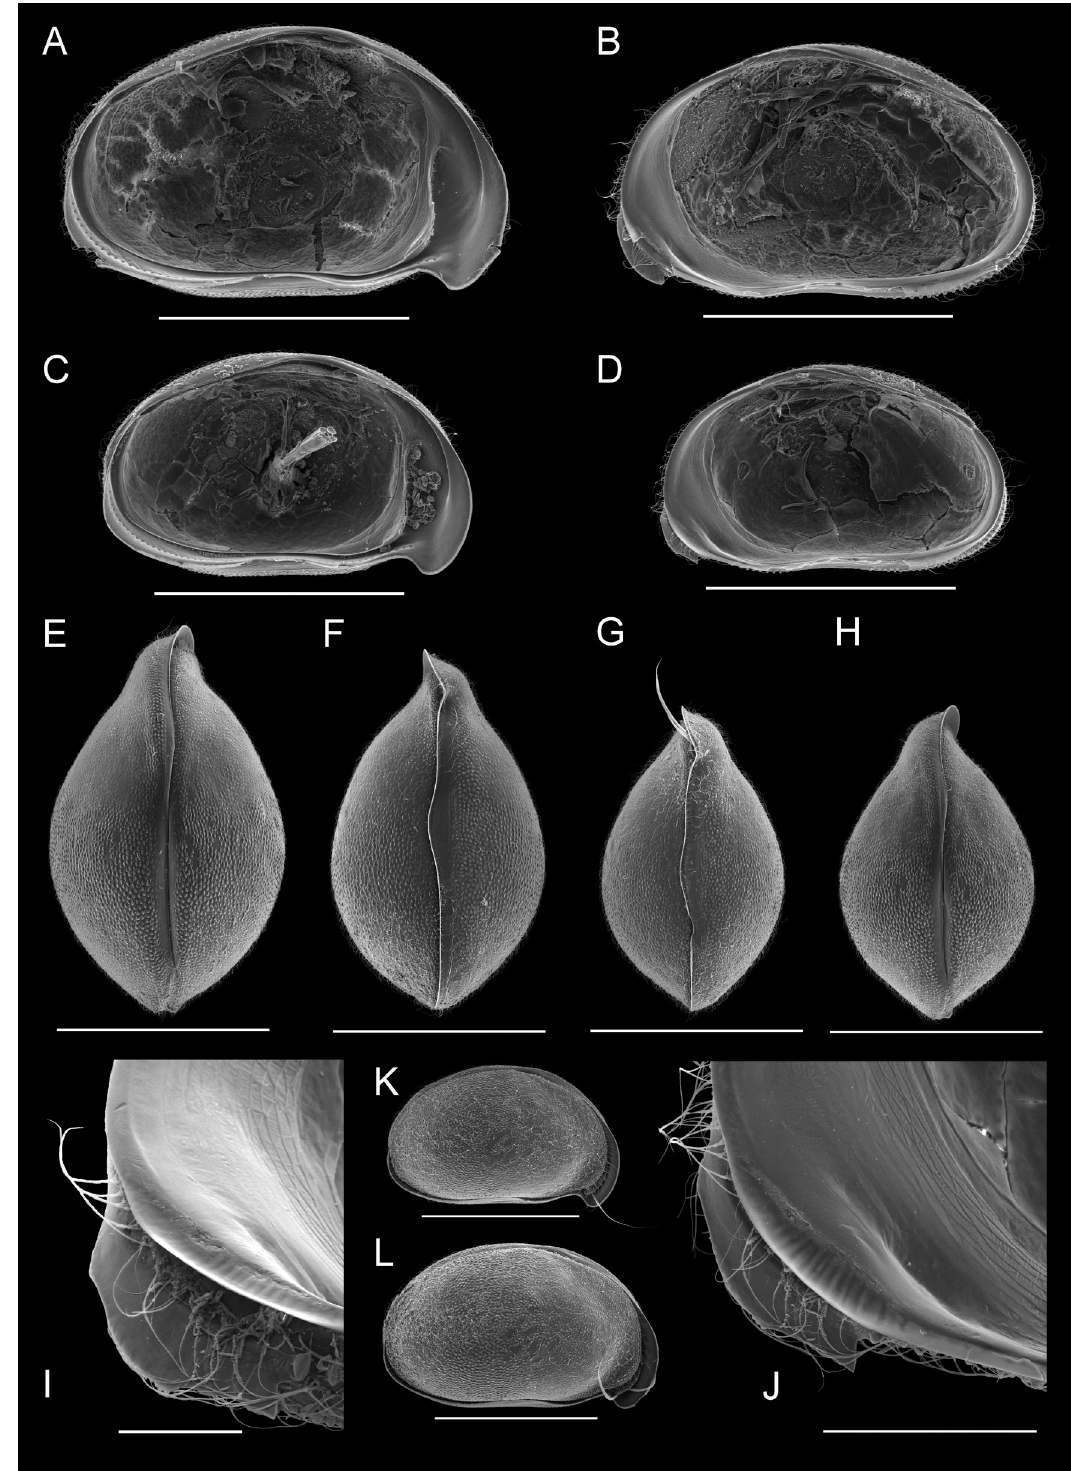
Fig. 7. Bennelongia regina sp. nov., all from Horseshoe Lagoon, QLD (Type locality). A . ♀, LVi (W40061). B . ♀, RVi (W40061). C . Holotype ♂, LVi (W40060). D . Holotype ♂, RVi (W40060). E . ♀, Cp dorsal (W40067). F . ♀, Cp ventral (W40066). G . ♂, Cp ventral (W40063). H . ♂, Cp dorsal (W40062). I . Holotype ♂, RVi detail anteriorly (W40060). J . Holotype ♂, RVi detail anteriorly (W40060). K . ♂, CpRl (W40064). L . Allotype ♀, CpRl (W40074). Scales: A-H, K-L = 1000 μm, J = 200 μm, I = 100